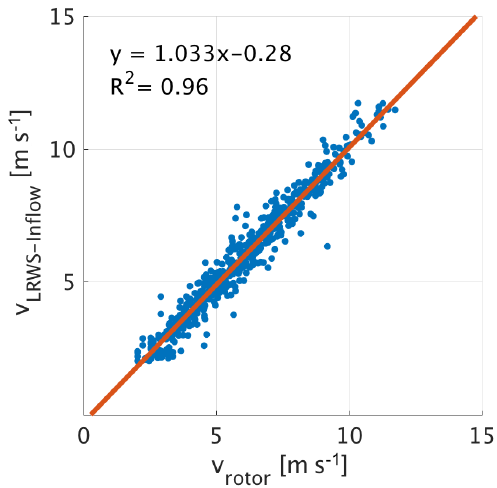
Figure 4. Correlation of the wind speeds derived from the diamond scan to the rotor-equivalent wind speeds. The correlation is derived by 589 10min periods.